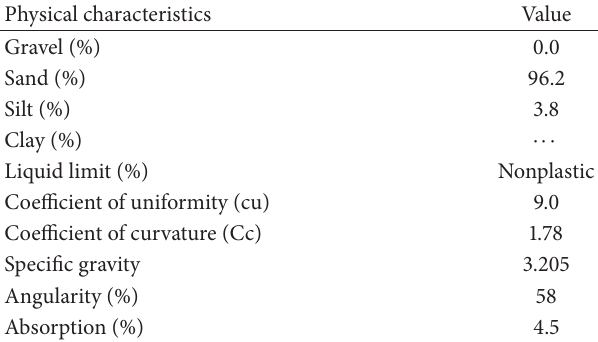
Table 2: Physical characteristics of fine steel slag aggregate.